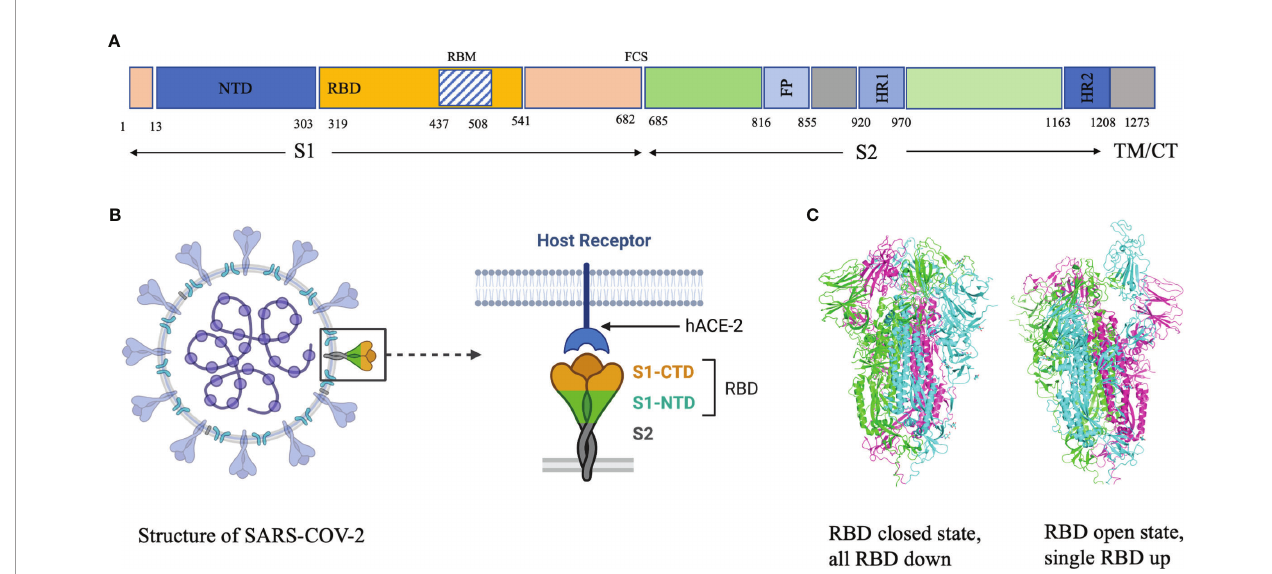
FIGURE 1 | (A) Domain architecture of SARS-COV-2 spike protein. (B) Structure of SARS-COV-2 virus and interaction of the receptor binding domain with human angiotensin converting enzyme 2 (hACE-2). (C) Trimeric spike protein showing RDB in closed state (down conformation, left) and open state (up conformation, right). Each color represents a monomer. RBD, receptor binding domain; CTD, C-terminal domain; NTD, N-terminal domain, hACE-2, human angiotensin converting enzyme-2; S1, spike protein 1; S2, spike protein 2; CT, Cytoplasmic tail; TM, transmembrane domain; FCS, Furin cleavage site, the numbers refer to amino acid residues. Figure created using Biorender, Pymol and Microsoft